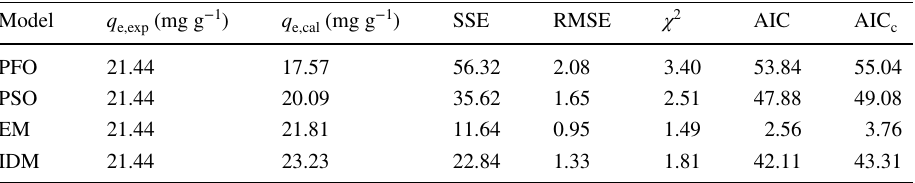
Table 3 Model validity evaluation among the various kinetic models used in